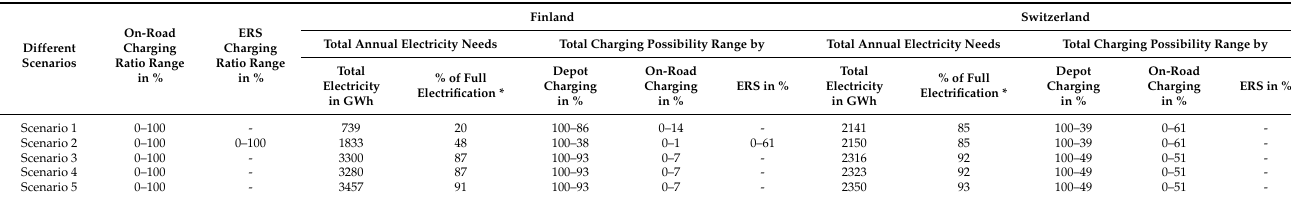
Table 6. Sensitivity analysis of the maximum charging possibility demand based on the on-road and ERS charging ratio variation.